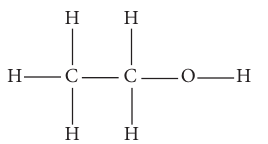
Figure 1: The biochemistry structure of